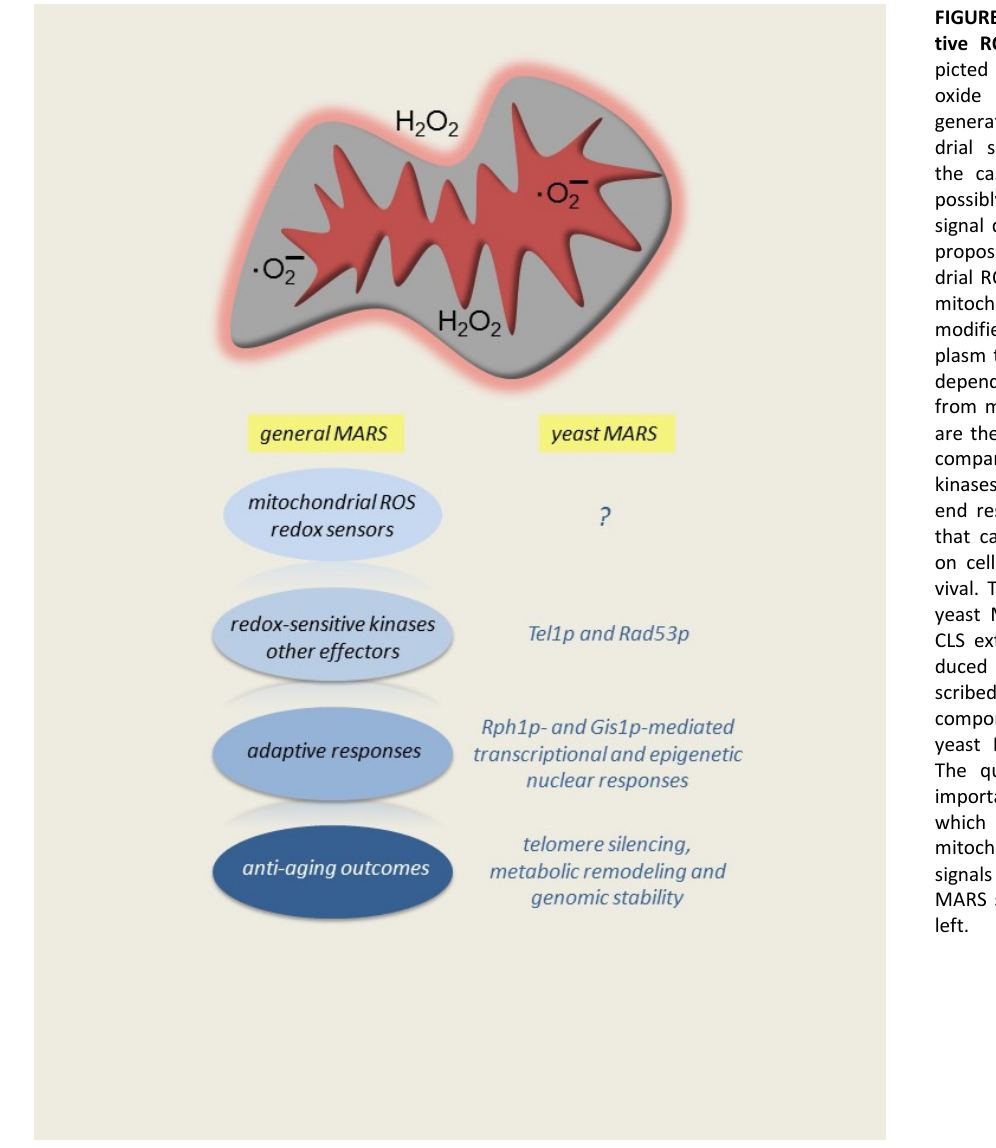
FIGURE 1: Mitochondrial Adap- tive ROS Signaling (MARS). De- picted at the top are ROS (super- oxide and hydrogen peroxide) generated in various mitochon- drial subcompartments, and, in the case of hydrogen peroxide, possibly crossing membranes to signal directly in the cytoplasm. I propose that there are mitochon- drial ROS sensors associated with mitochondria that can directly be modified by ROS or in the cyto- plasm that can detect some ROS- dependent second messenger from mitochondria. MARS signals are then relayed to other cellular compartments by redox-sensitive kinases or other effectors. The end result is an adaptive change that can have a beneficial effect on cellular homeostasis and sur- vival. To the right is the budding yeast MARS paradigm, based on CLS extension in response to re- duced TORC1 signaling as de- scribed in the text. Specific known components and outcomes of yeast MARS system are shown.